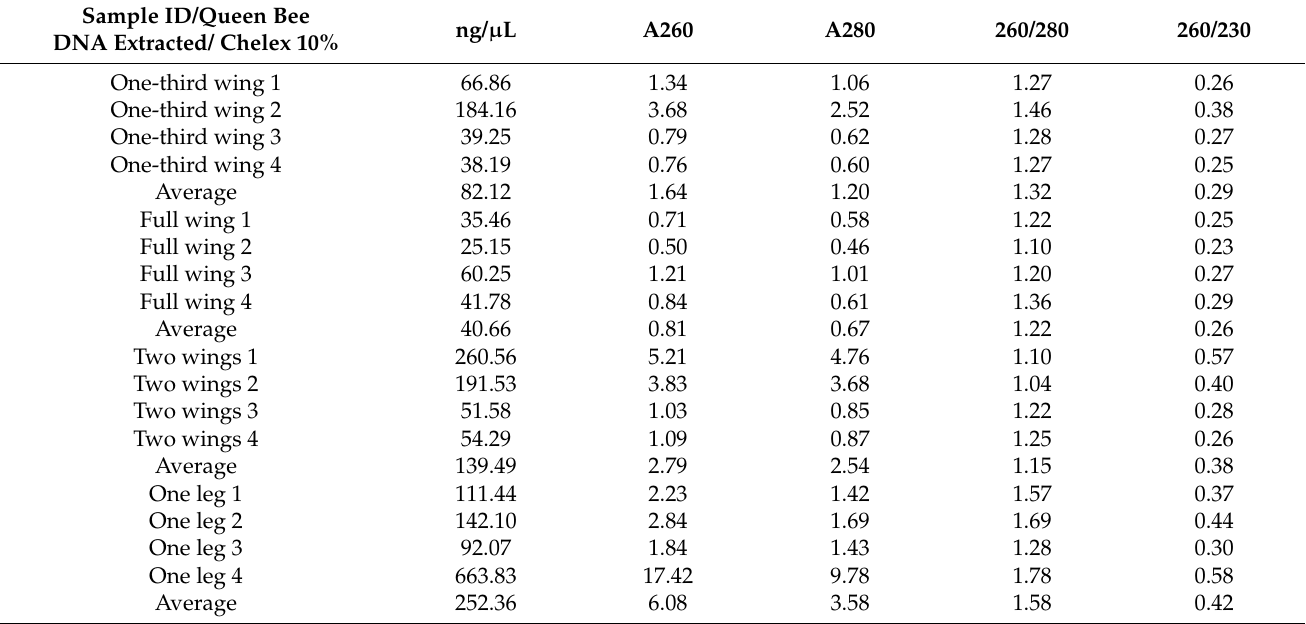
Table 2. Spectrophotometric results of Chelex 10% DNA extraction conducted on queen wings and legs. Tissues used were one-third of a queen wing, one full wing, two wings and one leg. Four biological replicates were tested and averaged for each category. The quantity of DNA is represented by (ng/ µ L), and DNA purity is reflected by both (260/280 and 260/230)